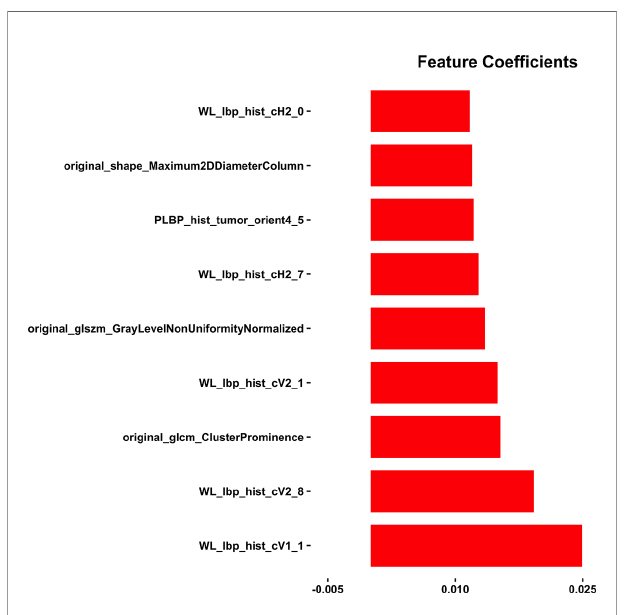
FIGURE 3 | The coef fi cients of the nine radiomics features by using the random forest (RF)